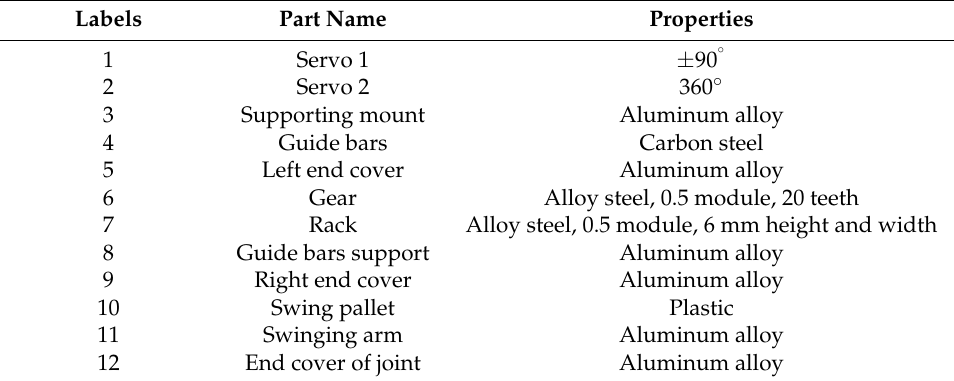
Table 1. Components of the snake-like robot.